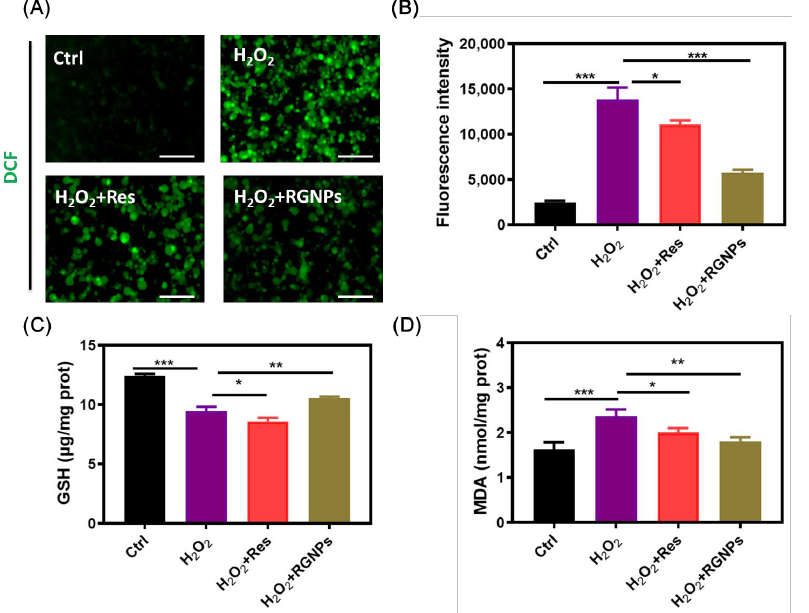
Figure 3. Anti–oxidant effect of RGNPs. ( A ) Confocal laser scanning microscope (CLSM) images of HLECB3 cells stained by 2,7-Dichloro-fluorescein diacetate (DCFH–DA, ROS probe) after treatment with different formulations (Ctrl, H 2 O 2 , H 2 O 2 + Res, H 2 O 2 + RGNPs) for 12 h; the bar was 50 µ m. ( B ) Fluorescence intensity of HLECB3 cells stained by a DCFH–DA probe after treatment with different formulations for 12 h. ( C ) Intracellular glutathione (GSH) level of HLECB3 cells after treatment with different formulations for 24 h. ( D ) Intracellular malondialdehyde (MDA) level of HLECB3 cells after treatment with different formulations for 24 h. *, ** and *** indicate p < 0.05, p < 0.01 and p < 0.001.